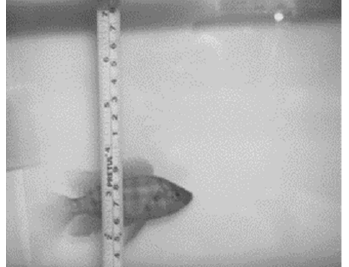
Figure 11. Pixels to centimeters conversion.